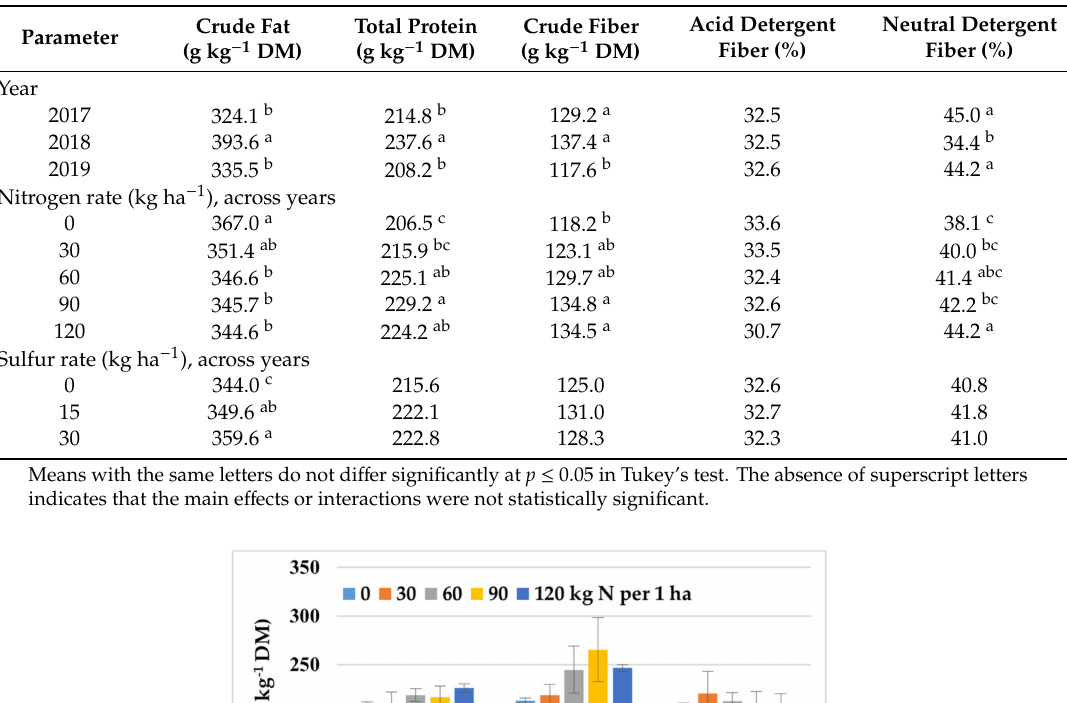
Table 5. Nutrient content of crambe seeds.